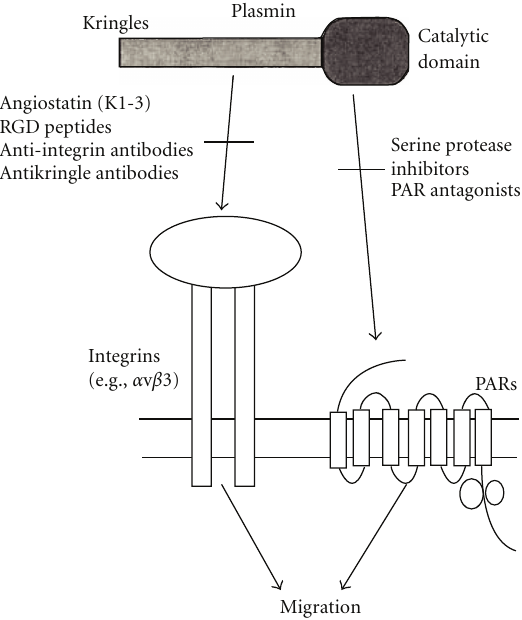
Figure 1: A model of plasmin-induced cell migration and the potential mechanism of angiostatin action. uPA activates plasminogen to plasmin pericellularly. Plasmin is accumulated on the cell surface by binding to integrins and stabilized. Free plasmin would be rapidly inactivated by circulating serine protease inhibitors (e.g., β 2-antiplasmin). The catalytic activity of plasmin on the cell surface is directly involved in signal transduction, possibly through activating G-protein coupled PARs. The binding of the kringle domain may not be directly involved in signaling through integrin pathways. Angiostatin e ff ectively blocks plasmin-induced cell migration possibly by competing with plasmin for binding to integrins. Aprotinin, a serine protease inhibitor, also e ff ectively blocks migration. It should be noted that other antiangiogenic agents, RGD-peptide and anti- α v β 3, are e ff ective inhibitors of this